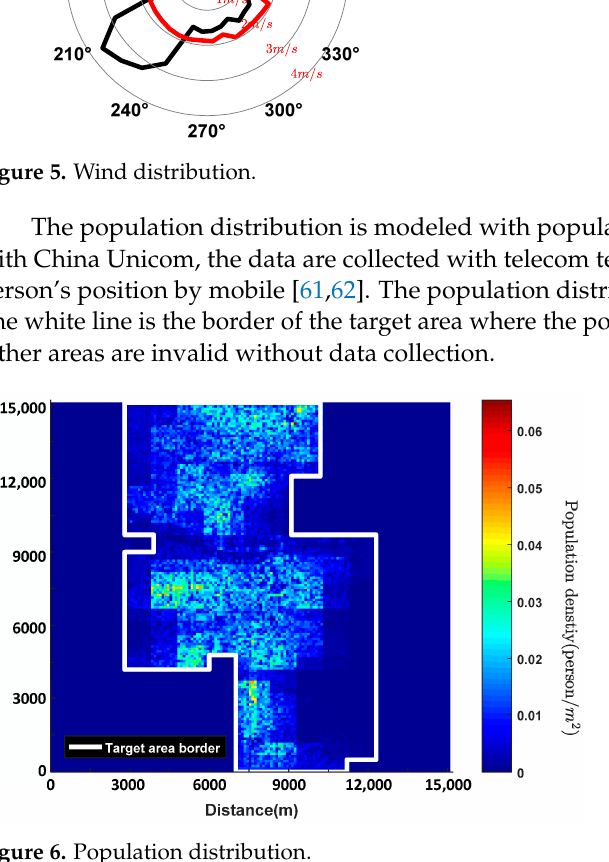
Figure 6. Population distribution.